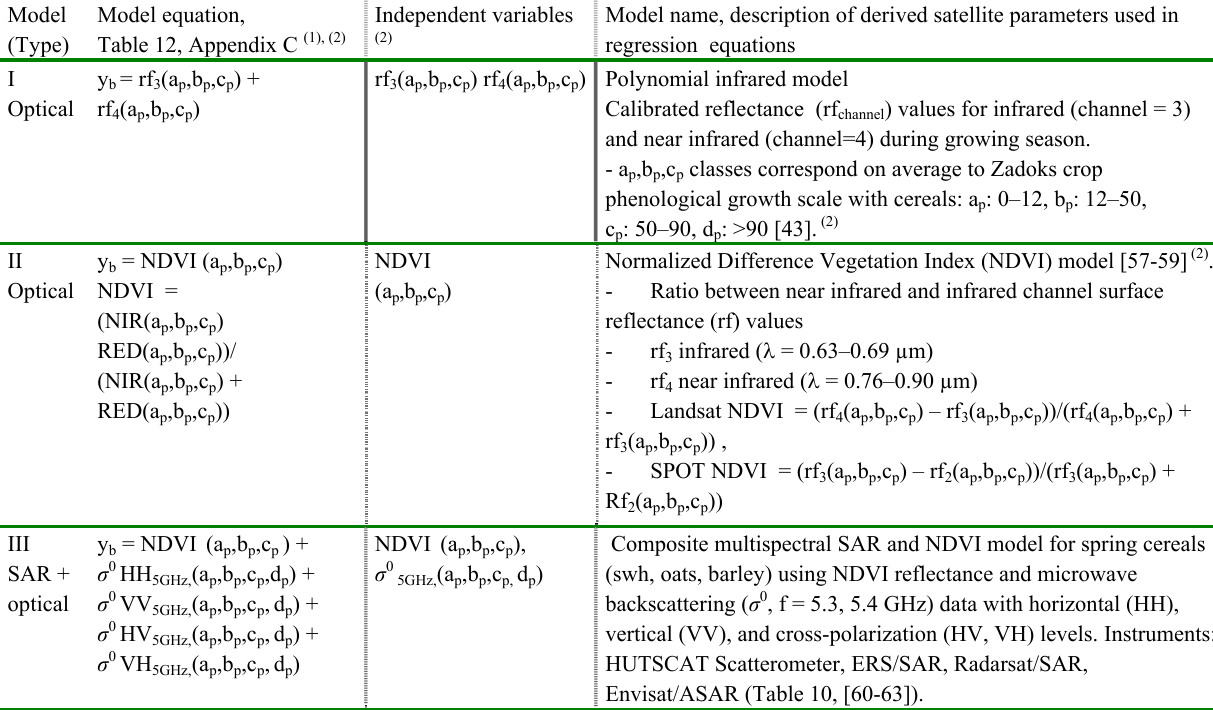
(1) Model equations presented in Table 12 (Appendix C), for abbreviations refer to Table 7. (2) Independent variables classified with SatPhenClass-algorithm (Figure